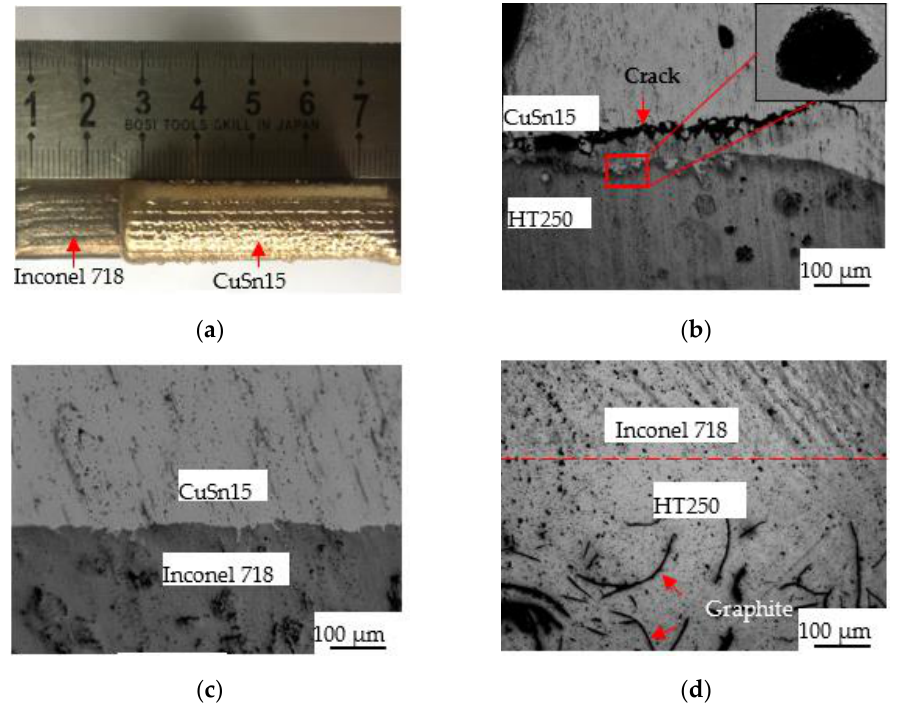
Figure 4. The morphology of the deposition layer and the relevant interface. ( a ) Inconel 718 and CuSn15; ( b ) the interface between CuSn15 and HT250; ( c ) the interface between CuSn15 and Inconel 718; ( d ) the interface between Inconel 718 and HT250.